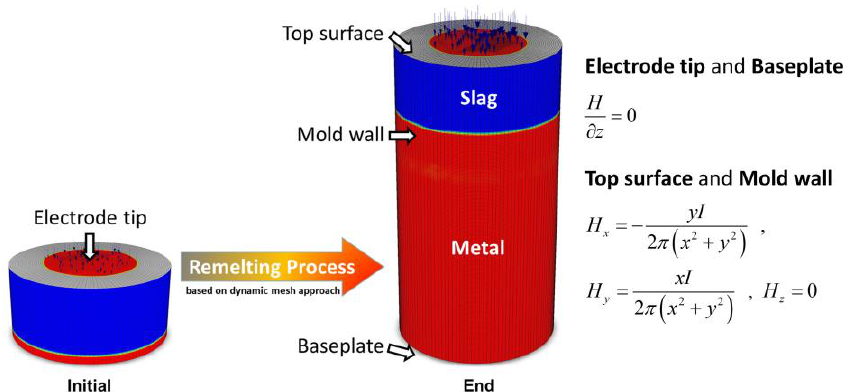
Figure 2. Mesh model with required magnetic boundary conditions.